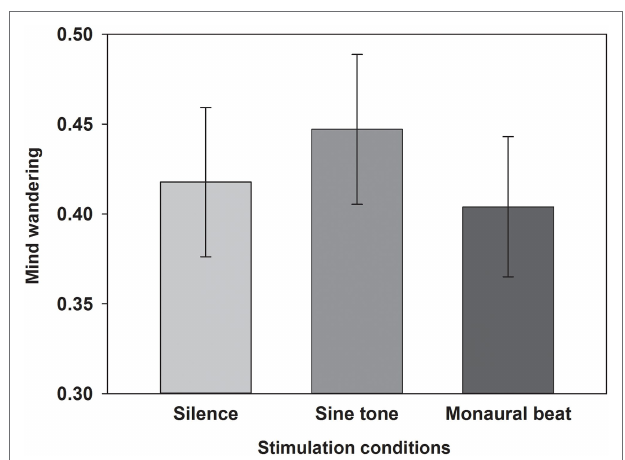
FIGURE 2 | Propensity to mind wander. The average propensity to mind wander shown across subjects for the three stimulation conditions. Mean and SEM are